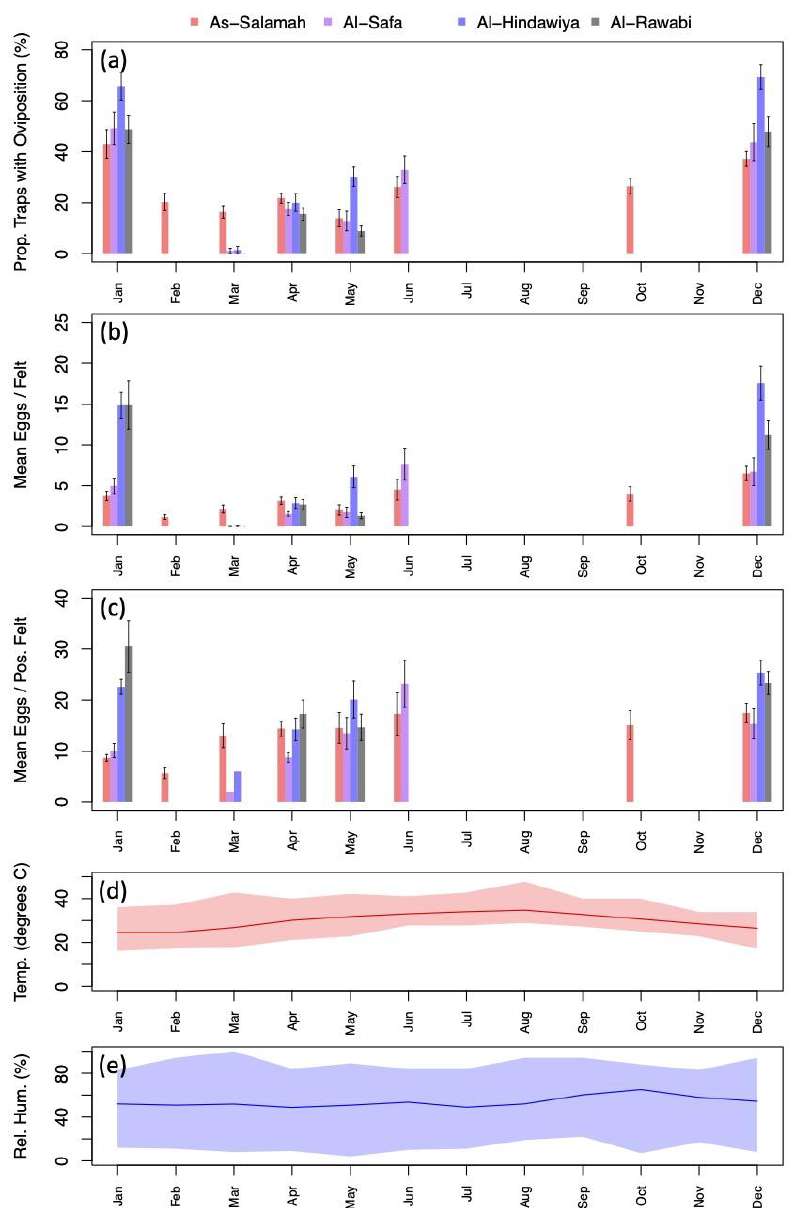
Figure 4. ( a ) Percentage of traps with oviposition by month (aggregated across study sites); ( b ) mean number of eggs deposited per felt by month (aggregated across sites); ( c ) mean number of eggs deposited per positive felt by month (aggregated across sites); ( d ) mean monthly temperature (line) with monthly minimums and maximums spanned by colored regions; ( e ) mean monthly relative humidity (line) with monthly minimums and maximums spanned by colored regions. Black intervals extending from barplots in ( a – c ) show ± one standard